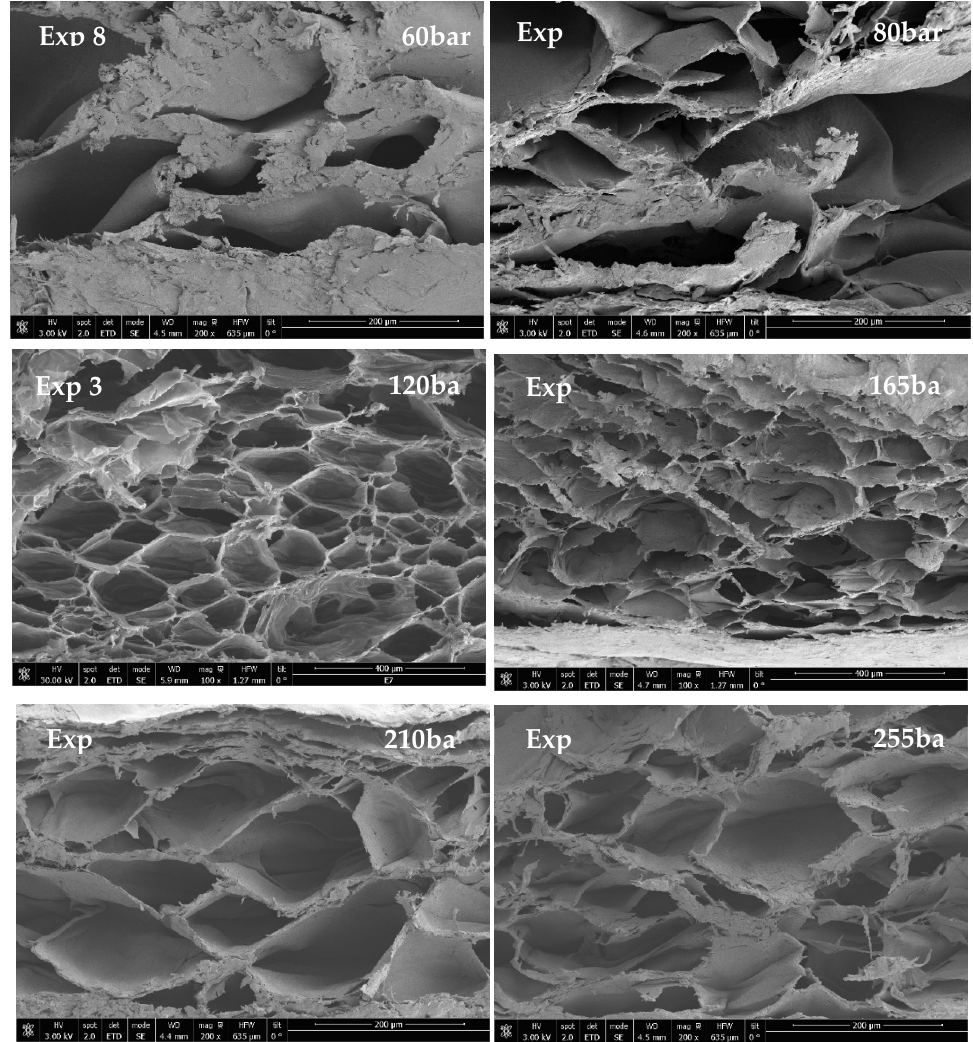
Figure 8. SEM images of formed scaffolds at 45 °C of temperature and 30 min of contact time at different operating pressures.